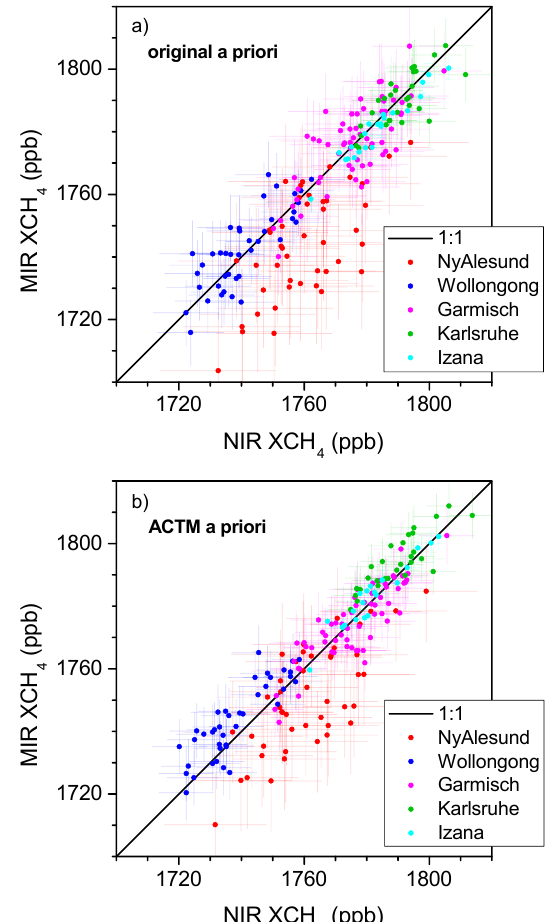
Figure 1. (a) Scatter plot of MIR and NIR monthly means, both series retrieved with the standard retrieval a priori profiles. Error bars on data points are 2 σ uncertainties derived from the SD of the √ linear slope fit (2 SD / 2). (b) Same as (a) but for using ACTM profiles as common